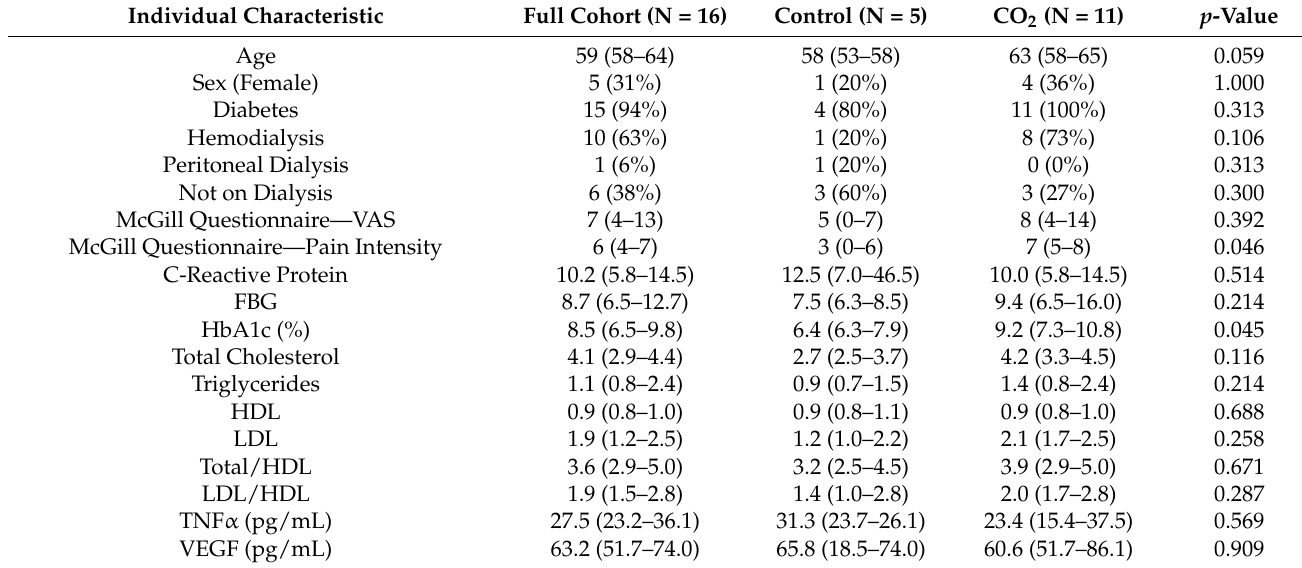
Table 3. Baseline characteristics, fasting blood glucose, HbA1c, lipid profile and wound/limb characteristics of patients enrolled into the